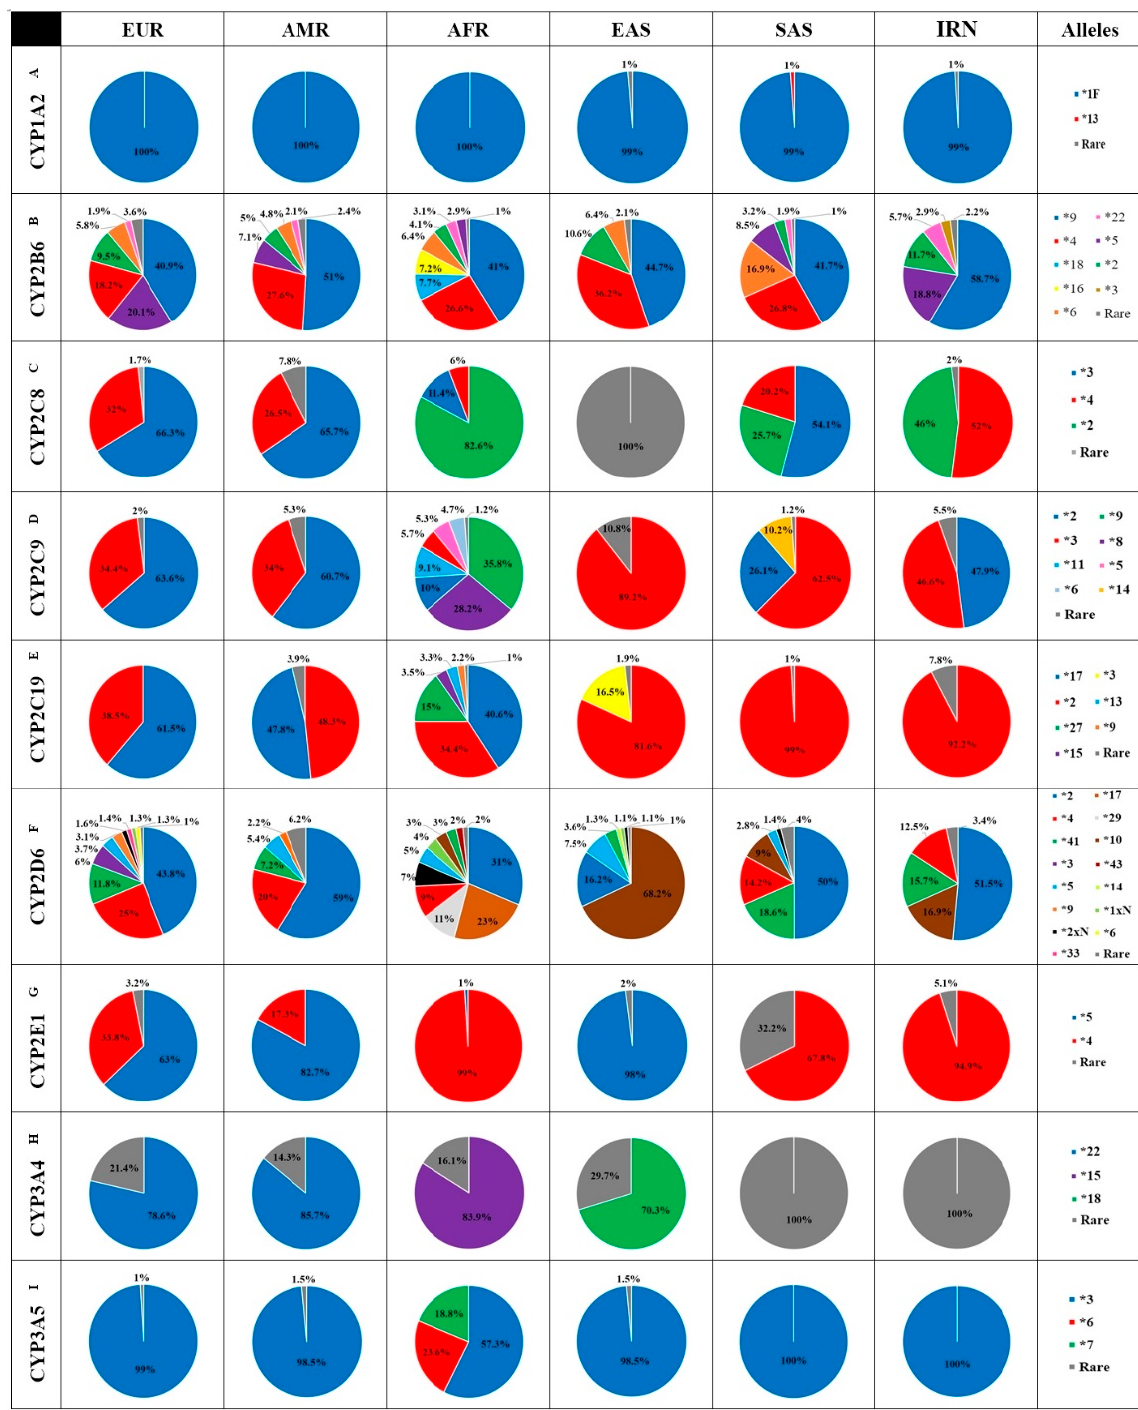
Figure 2. Distribution of the relative contributions of 9 major cytochrome P450 (CYP) alleles in Iranian, European, Latino/Admixed American, African, East Asian and South Asian populations. Pie charts showing the relative contribution of common variants in CYP1A2 ( A ), CYP2B6 ( B ), CYP2C8 ( C ), CYP2C9 ( D ), CYP2C19 ( E ), CYP2D6 ( F ), CYP2E1 ( G ) CYP3A4 ( H ), and CYP3A5 ( I ) in five major populations compared to Iranian population. Only variants with a minor allele frequency in the respective population above 1% are shown, whereas all other variants analyzed in this study are summarized as “rare” (grey).